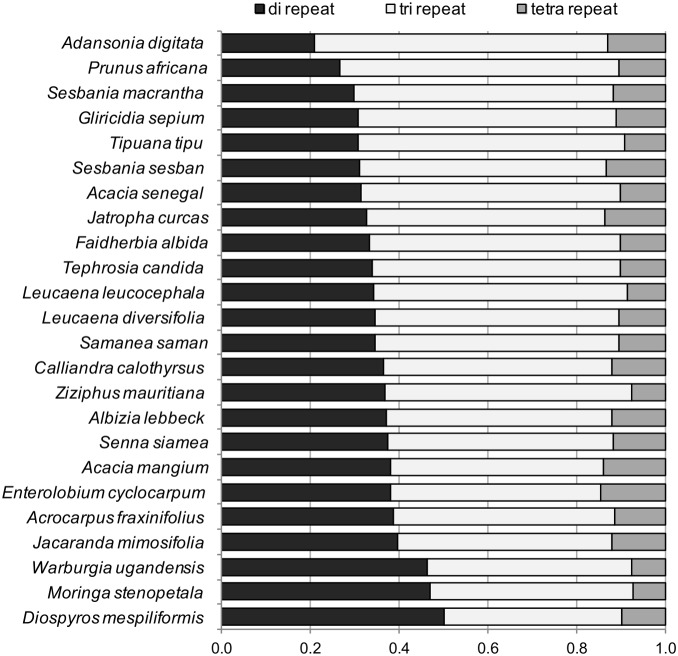
SSR repeats in 24 tree species subjected to next-generation sequencing.The proportion of di-, tri- and tetra-nucleotide repeats is shown. The species are ordered by the proportion of di-nucleotide repeats revealed.